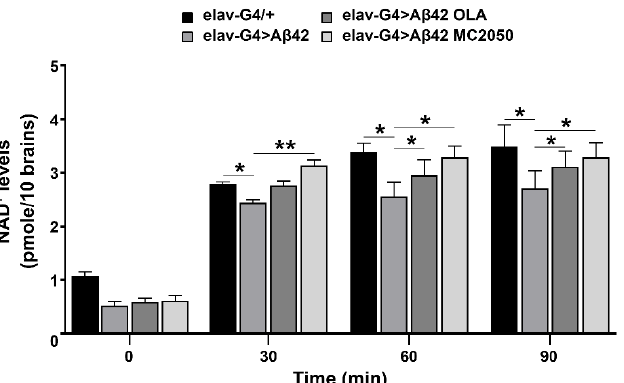
Figure 2. PARP-1 induces NAD + depletion. NAD + levels were determined by the use of a dedicated colorimetric kit from Merck-Sigma-Aldrich, following manufacturer’s instructions. Elav-Gal4 > A β 42 flies were treated as described in the Material and Methods section. Elav-Gal4/+ was considered as control. Data represented mean ( ± SEM) of three independent experiments. Statistical analysis was performed by one-way ANOVA and Turkey post hoc test (* p < 0.05, ** p <